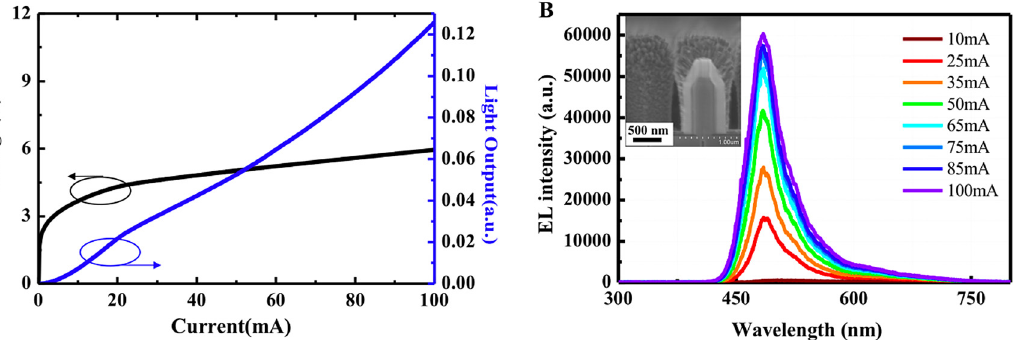
Figure 3: Current – voltage – light output ( I – V – L ) and the EL characterization of NW-LED in the sample a. (A) Current – voltage – light output ( I – V – L ) characteristics of the NW-LEDs of the sample a. (B) EL spectra measured under different current injections. Cross-sectional SEM images of the NWs coated with ITO are shown in the inset.